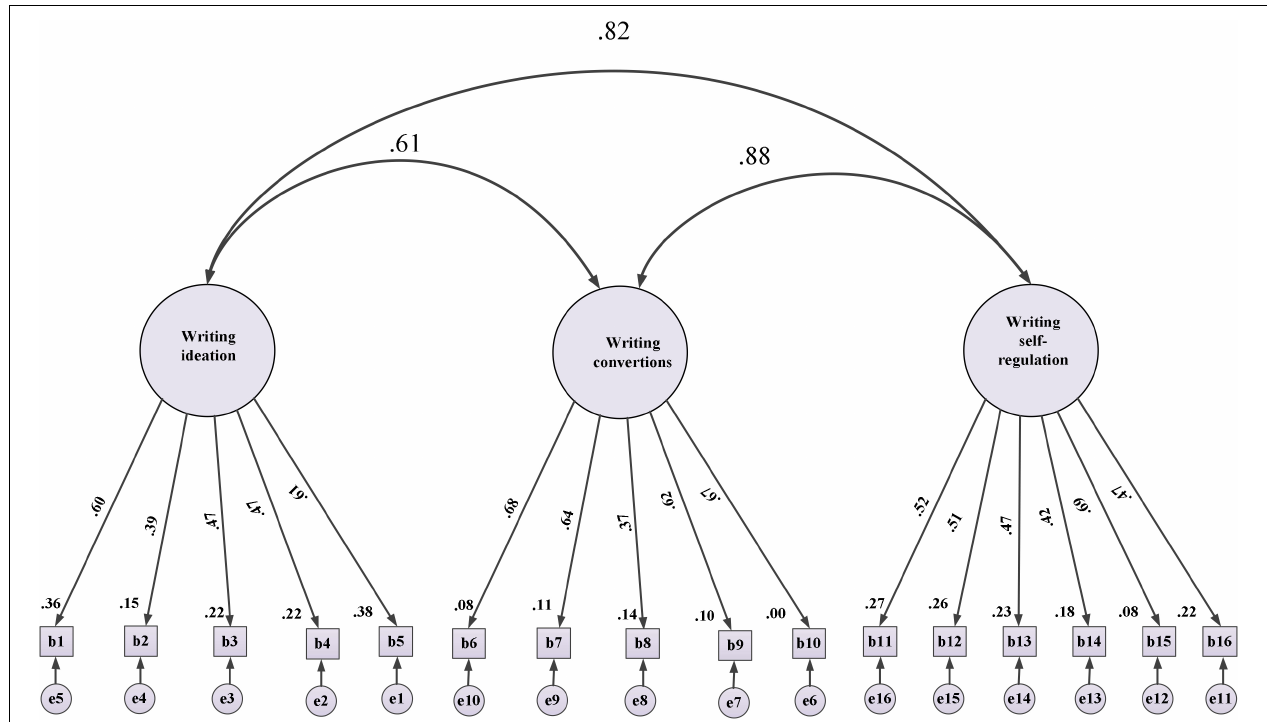
FIGURE 2 | Standardized ( β ) coefficients for confirmatory factor analysis (CFA) and error variance for writing self-efficacy (WSE).